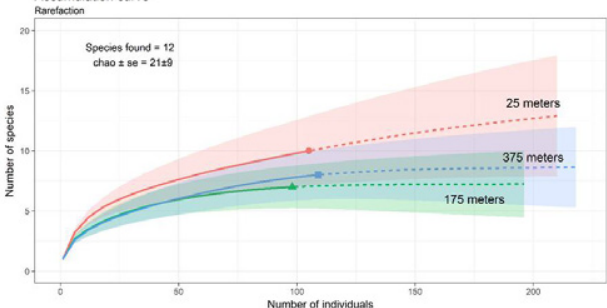
Fig 3 . Accumulation curve of species: number of species found versus number of expected species. Bee diversity on canola fields in Southern Brazil. Interpolation (solid lines) and extrapolation (dashed lines) of Hill number with order q. Note: shadow means confidence intervals